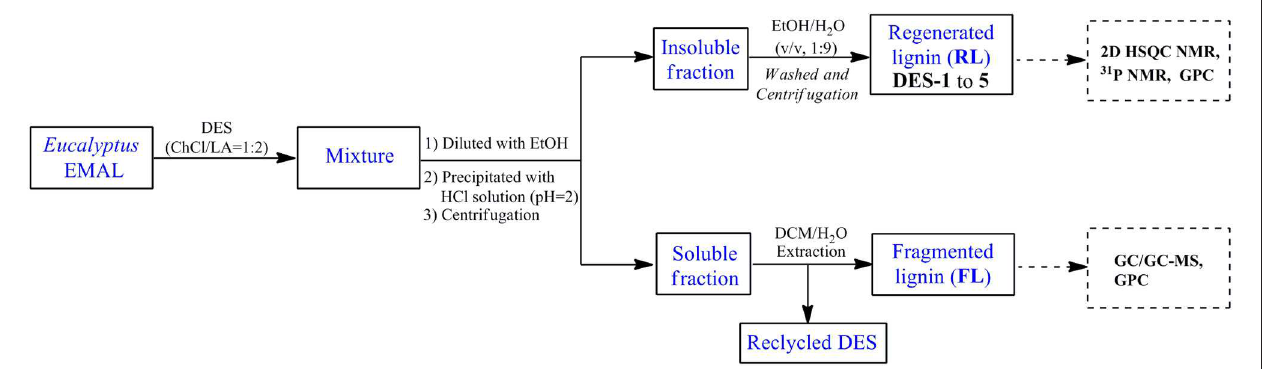
FIGURE 1 | The post-processing flowchart of lignin treatment with deep eutectic solvent (DES).